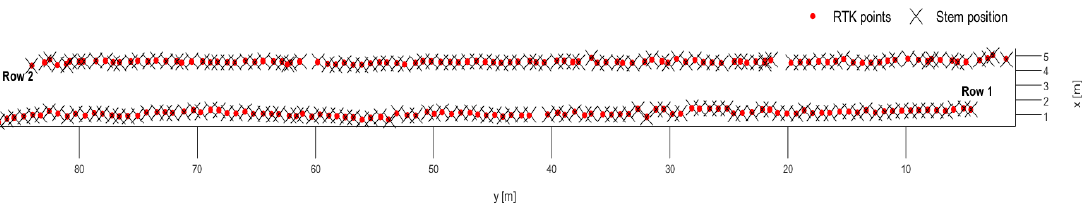
Figure6. Estimationofthetree(n = Figure 6. Estimation of the tree (n = 224) stem position compared to the RTK-GNSS defined stem position.